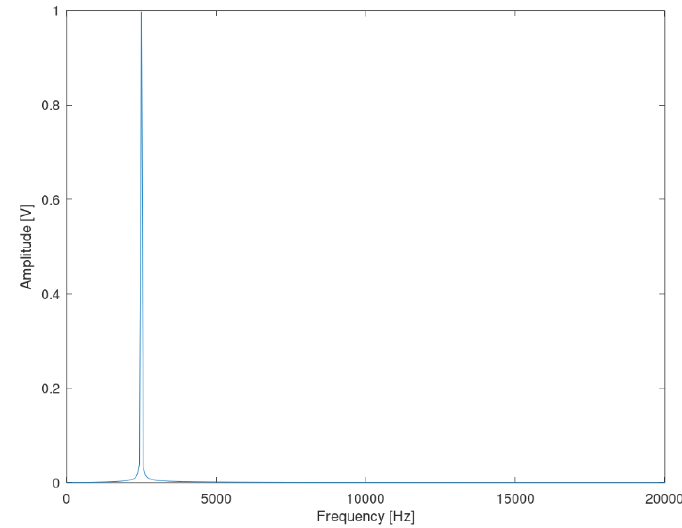
Figure 9. FFT results of the sine signal at 150 kHz in the frequency domain, when different obser- vation windows at the time domain are used. Observation time intervals are ( a ) 0.42 ms, ( b ) 0.4 ms,